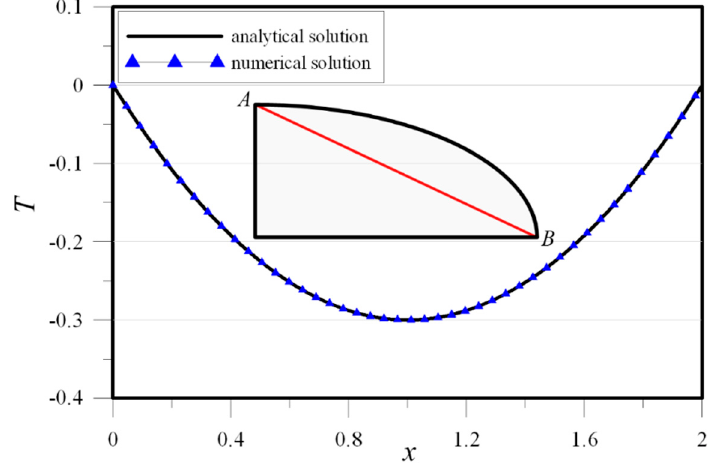
Figure 5. Comparison of temperature results with the analytical solution along line AB.